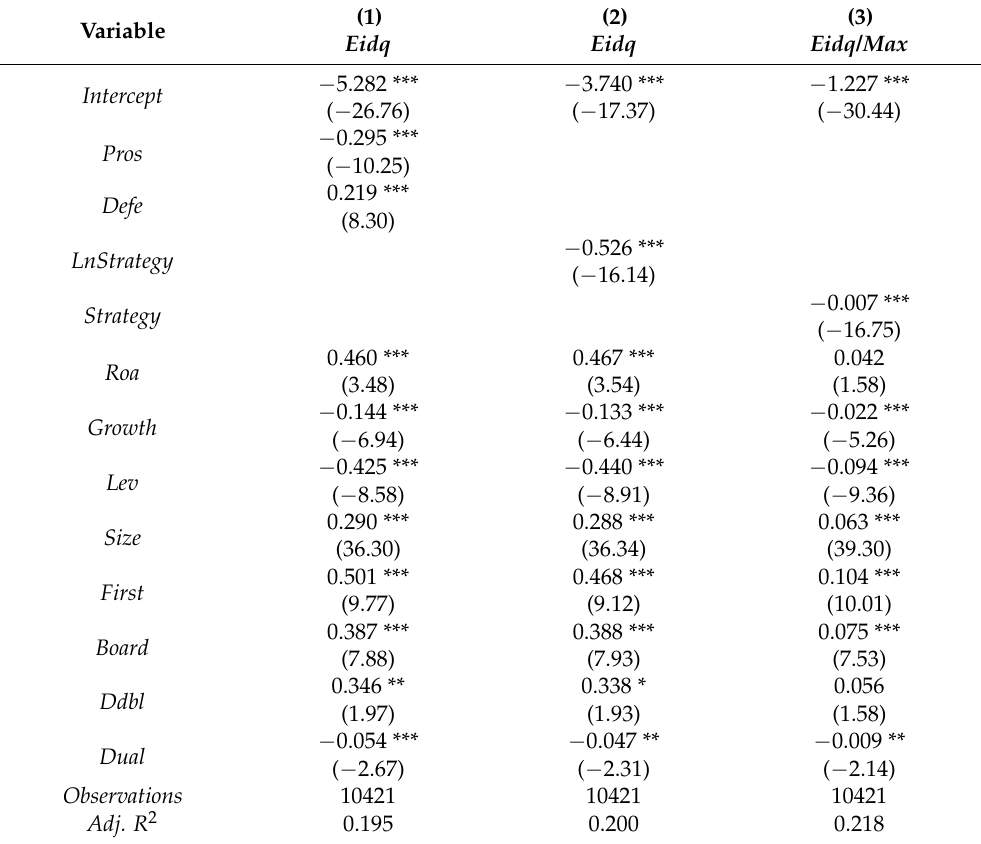
Table 8. Business strategy and environmental information disclosure quality: Measurement index sensitivity